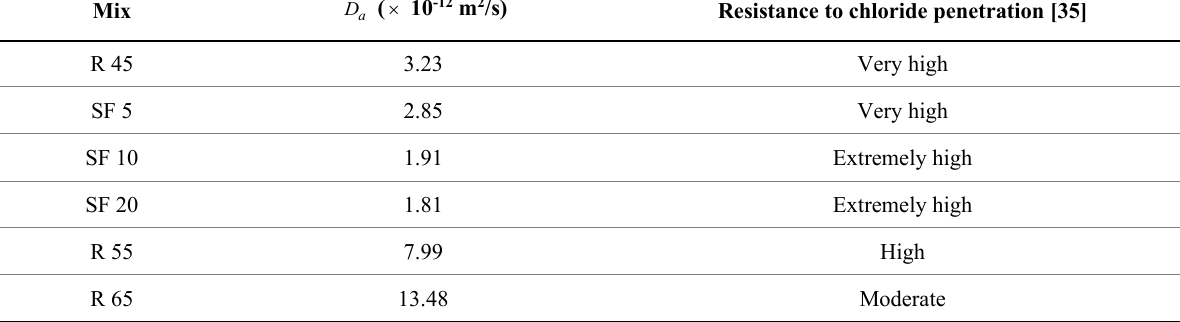
) obtained through ASTM C1556 [14] test method. a D